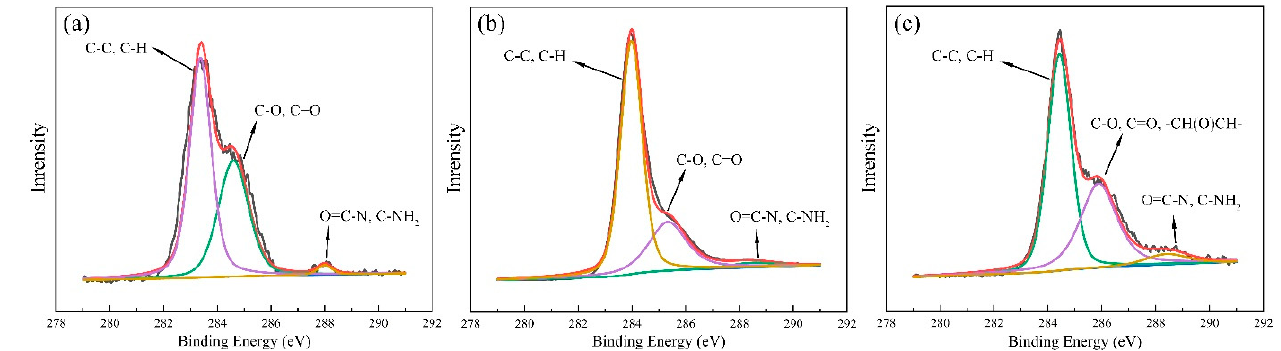
Figure 6. C 1S high-precision photon energy spectrum of the film: ( a ) CA/TPU film, ( b ) rGO@CA/TPU film, and ( c ) GO/rGO@CA/TPU film. Table 2. Changes in the elemental content of the nanofiber films during successive anchoring. Electrospun